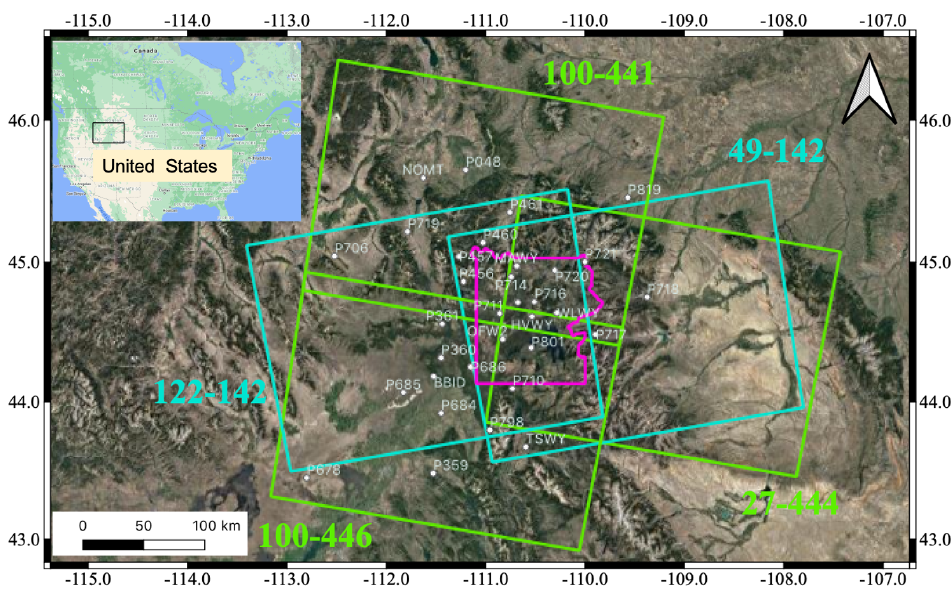
Figure 1. Sentinel-1 frames covering the Yellowstone area. The Yellowstone National Park boundaries are outlined with magenta. White markers show the locations of permanent GNSS stations in the area covered by the frames.